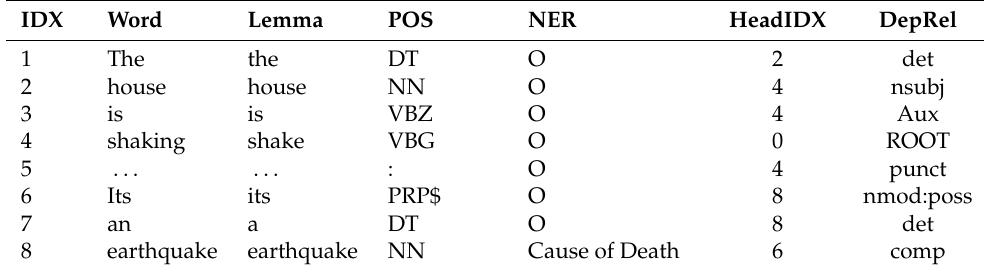
Table 5. Stanford CoreNLP